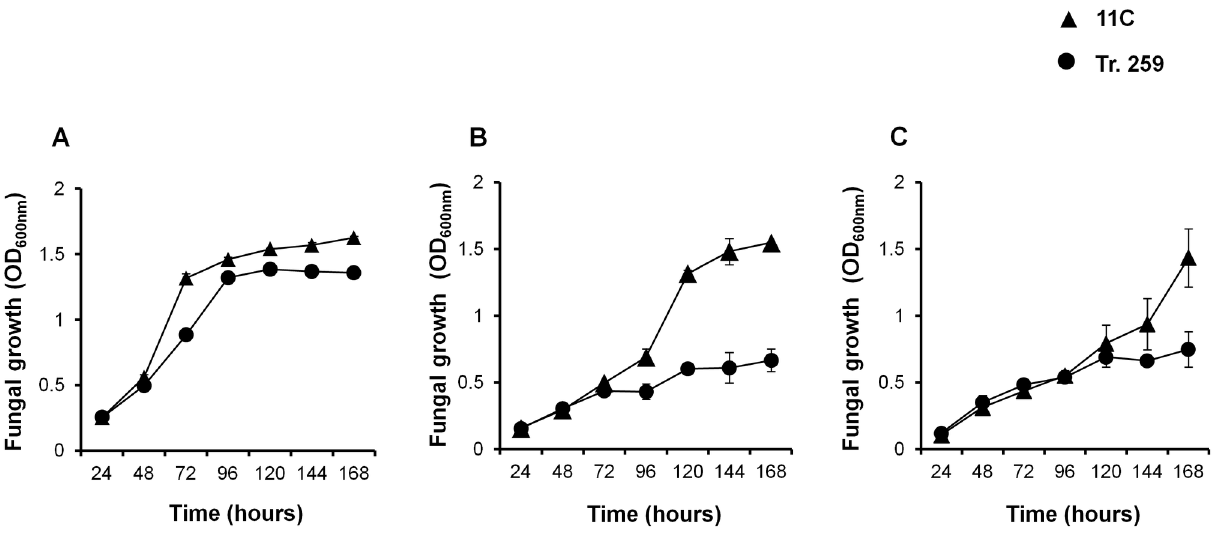
Figure 4. Temporal analysis of alcohol tolerance in F. oxysporum . Fungal conidial inoculum was produced in Mung bean broth [32] and resuspended in minimal medium [37] at a concentration of 10 6 ml -1 . A volume 100 µl conidia (10 6 ml -1 ) was added to microtiter (96-well; Sarstedt, Germany) plates with either no alcohol ( A ), ethanol (Ethyl absolute, Sigma, UK) at a concentration of 4% (vv -1 ) ( B ) or butanol ( n -Butanol Butyl alcohol, Sigma, UK) at a concentration of 0.75% (vv -1 ) ( C ). Fungi were maintained at 25°C for 168 hours and growth (OD ) was measured every 24 hours. Fungal growth (OD ) was measured using a 600nm 600nm spectrophotometer (Spectra Max 340 PC 96-well plate reader, Molecular Devices, USA). Bars indicate SEM. Growth of Tr. 259 significantly different from 11C is highlighted with an asterisk (level of significance: *<0.05, ** < 0.01). doi: